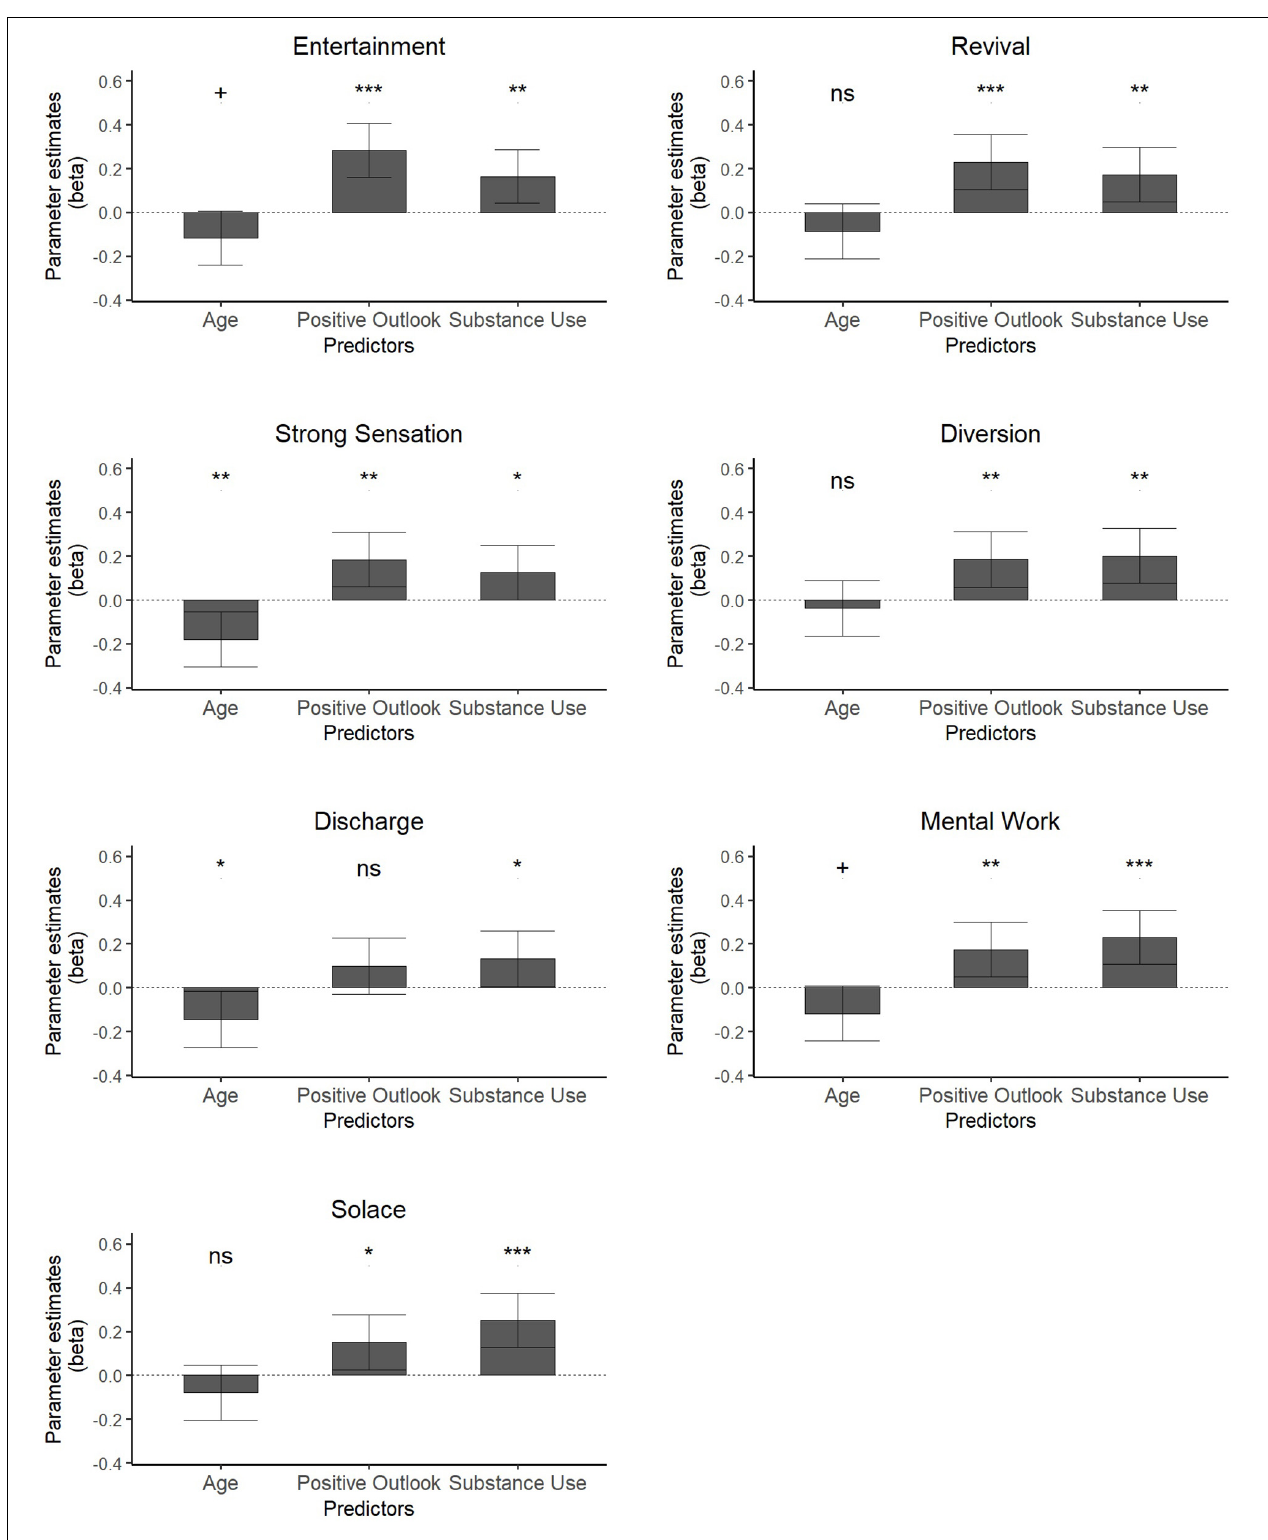
FIGURE 2 | Plots of parameter estimates of independent variables and MMR factors. Error bars indicate 95% confidence Intervals. * p < 0.05, ** p < 01, *** p < 0.001. + indicates non-significant